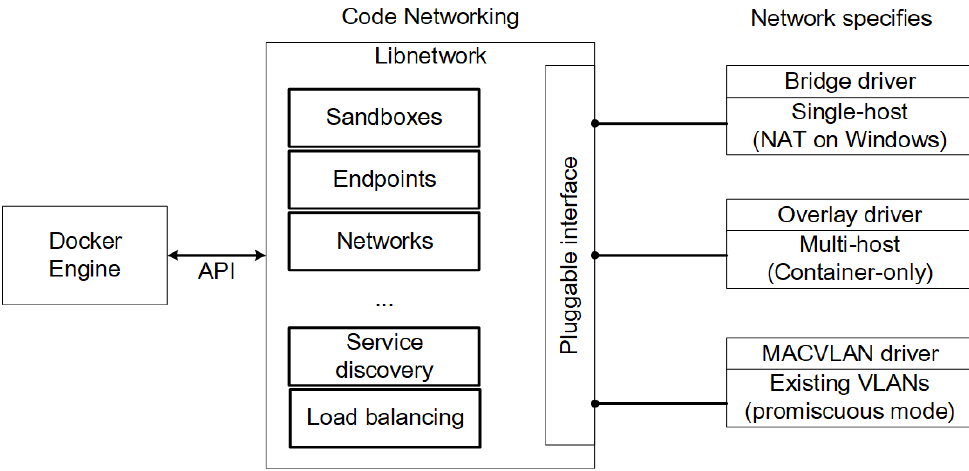
Figure 3. Driver components of the container network model.